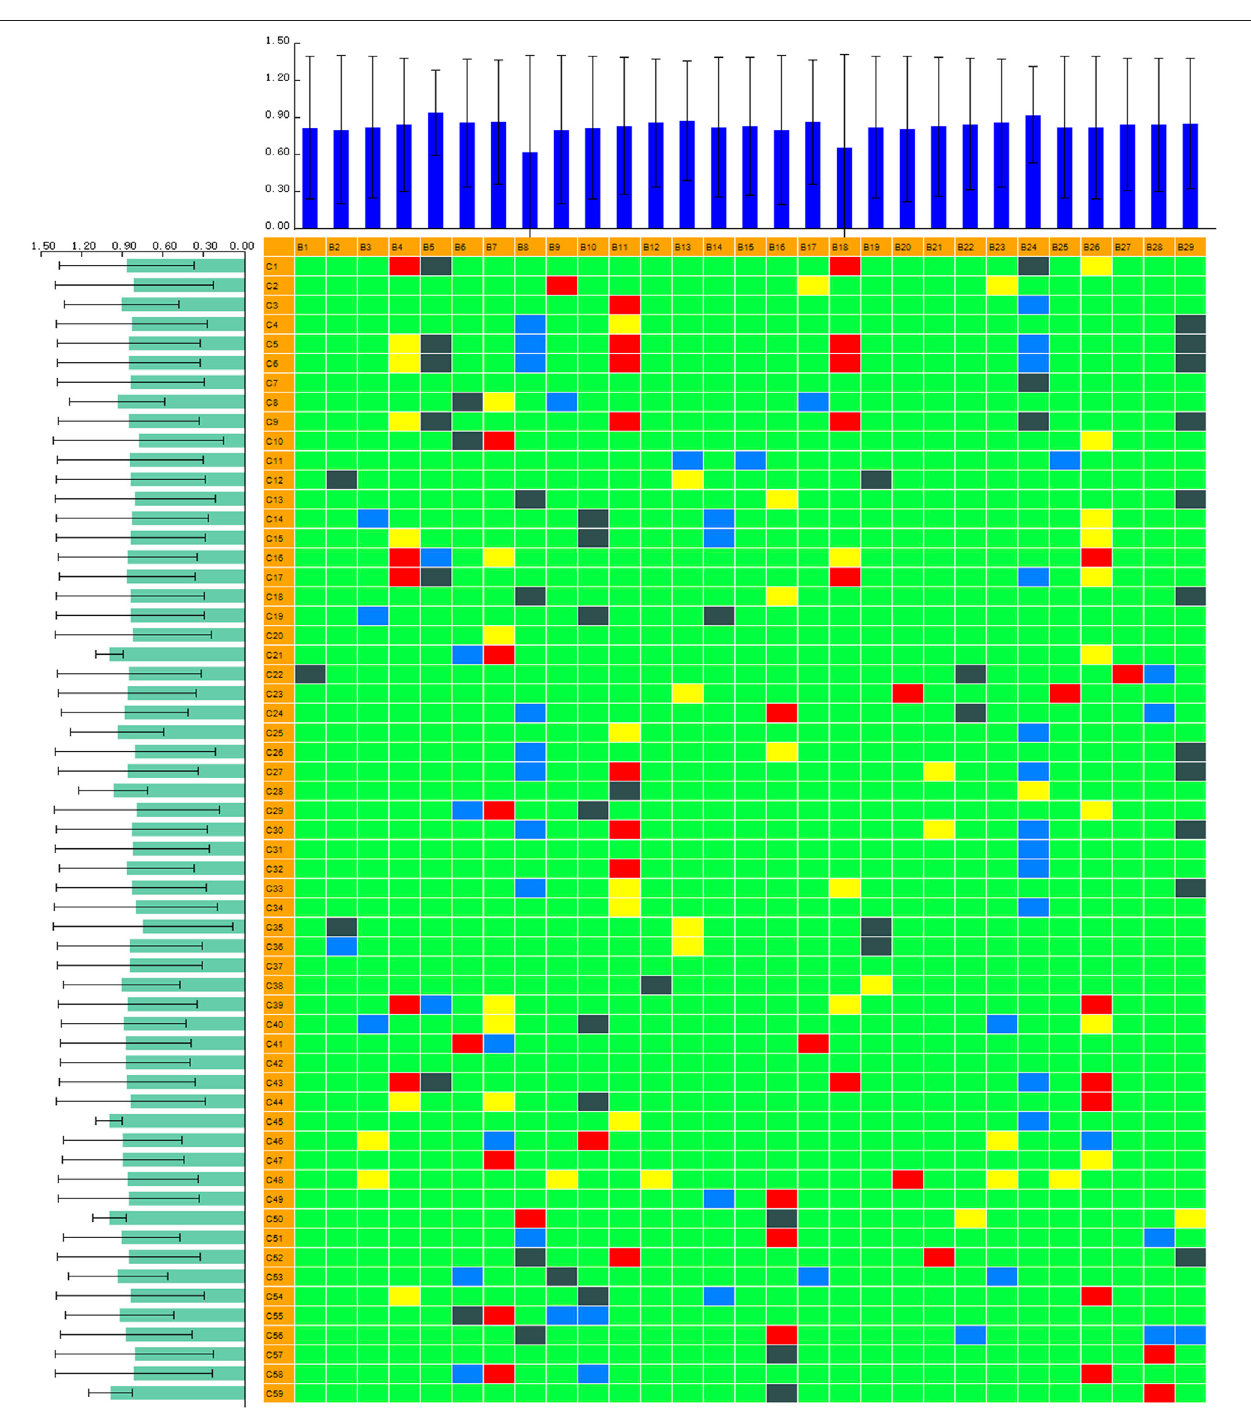
Frontiers in Pharmacology |